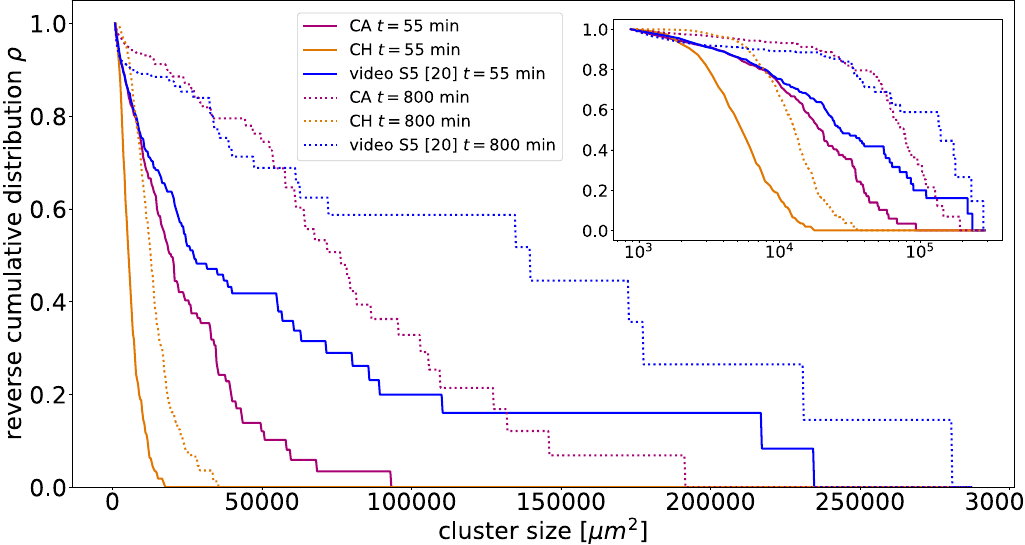
Fig 4. The cellular automaton reproduces the cluster size distribution ρ of the experiments of Me´hes et al. [20] for EPC with PFK closer than the Cahn-Hilliard model. Shown is the reverse cumulative probability that a randomly drawn cell belongs to a cluster of respective size. For both models and the video S5 from Ref. [20], two separate cluster size distributions are shown, one at an early stage ( t � 55min) and one at a later stage ( t � 800min). The cluster size distributions represent exclusively PFK clusters, since EPC as the more abundant cell type forms one large connected sea, which we ignore in the distributions. Note that clusters below 2 cells are neglected as they can not be resolved in the video, see S1 Text.